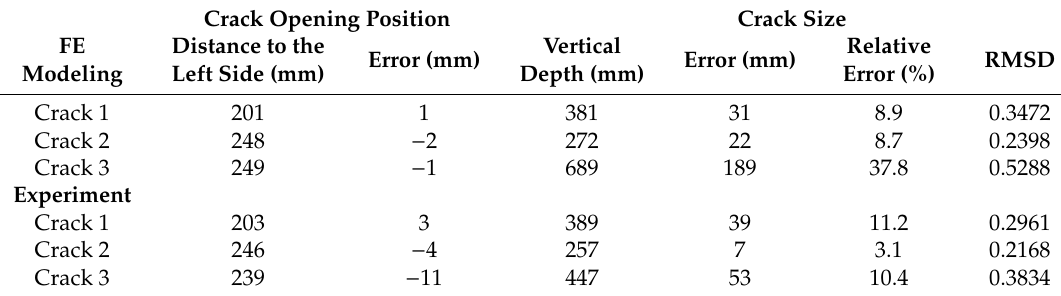
Table 3. Quantitative identification results of the crack.